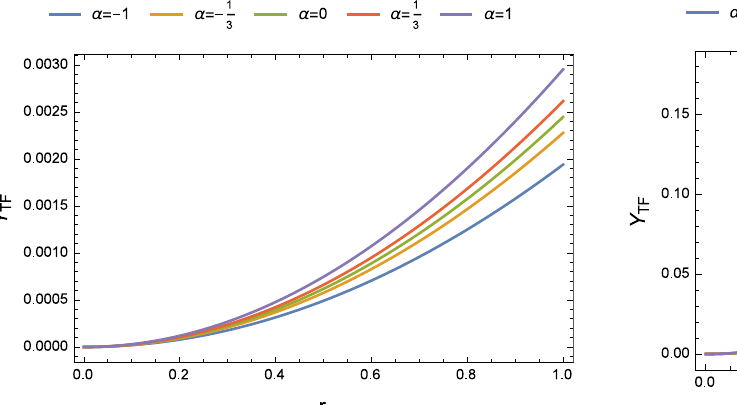
= − 20 and varying α TF vs the radial coordinate r for K